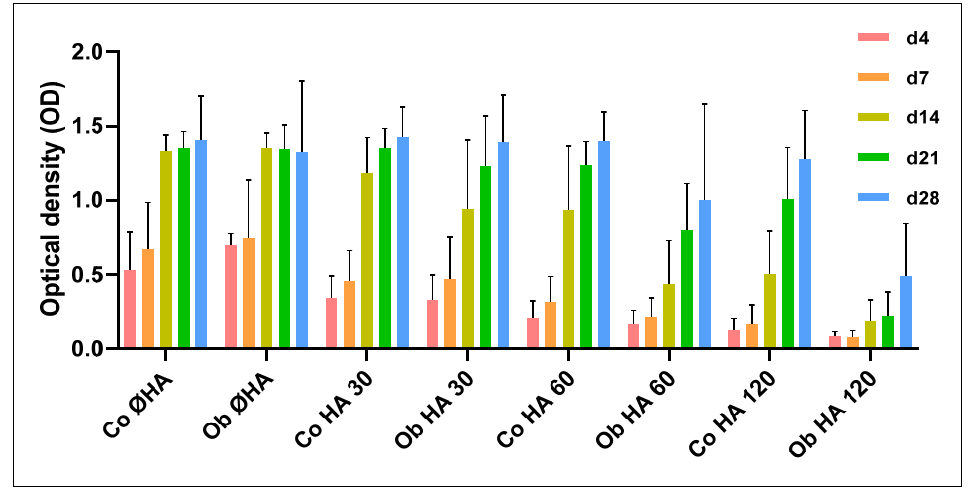
Figure 7. Detection of the optimal amount of HA for collagen/HA composites. Collagen gels or collagen/HA composites were prepared in a ratio of 1:1 (HA 30); 1:2 (HA 60), and 1:4 (HA 120). JPCs were cultured for 4–28 days within these constructs and metabolic activities were measured (at least 3 independent experiments). Optical densities (OD) of the measurements are illustrated. Note the decrease in cell viability with increasing HA amounts. Materials 2020 , 13 , x FOR PEER REVIEW Table 2. Statistical ANOVA analysis of JPC proliferation activities calculated in comparison to cells growing within collagen scaffolds without HA (groups Co Ø HA and Ob Ø HA from Figure 7). n.s. = not significant; Co = untreated control; Ob = osteogenically induced samples. Day 4 Day 7